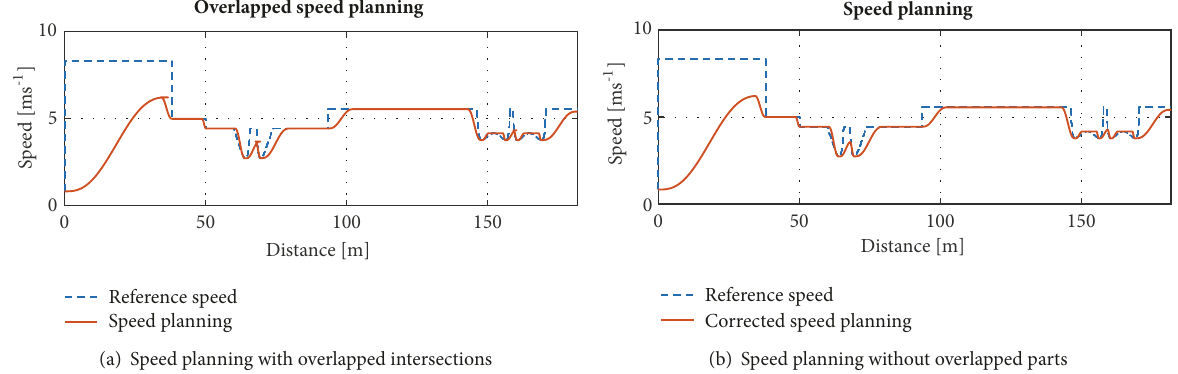
Figure 6: Stages for speed planning approach.